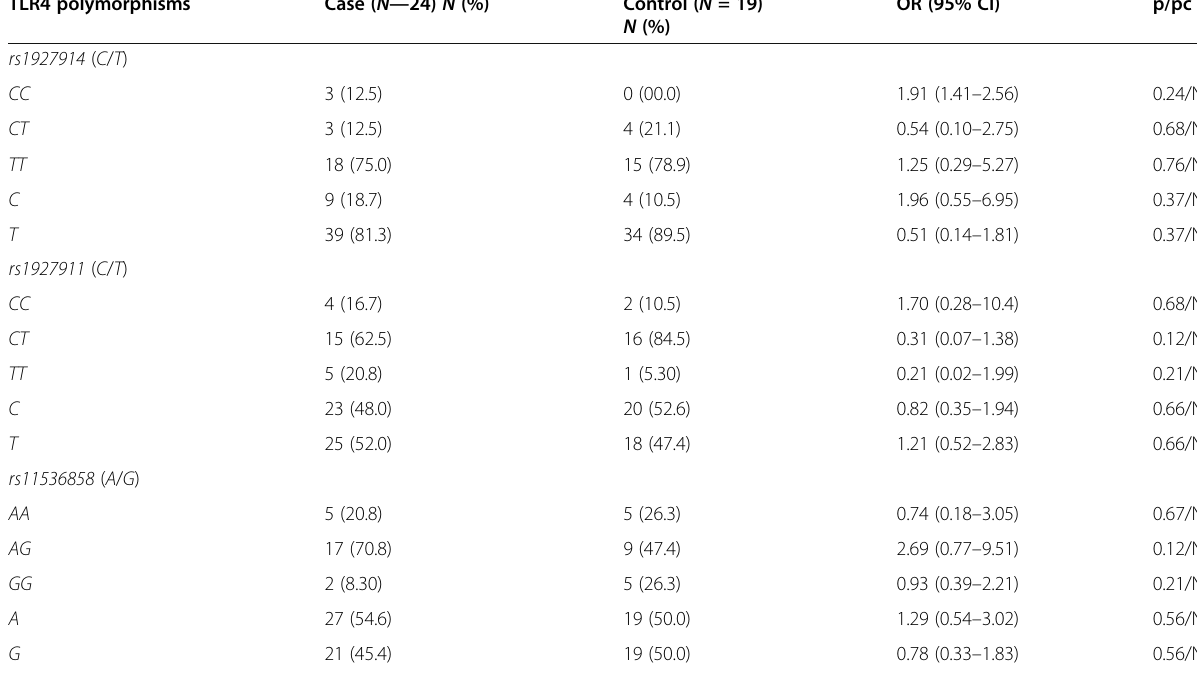
Table 3 Distribution of TLR4 alleles and genotypes Vitiligo patients and healthy controls (group 1: below 18 years)